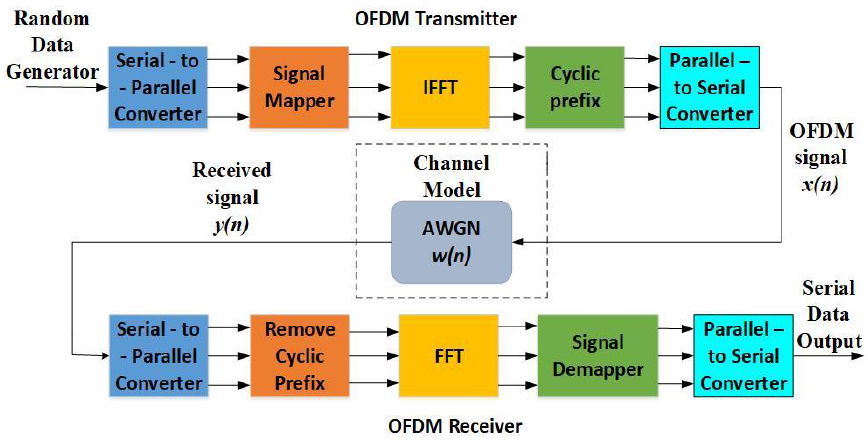
Figure 1. Block diagram of OFDM transmission and reception process.